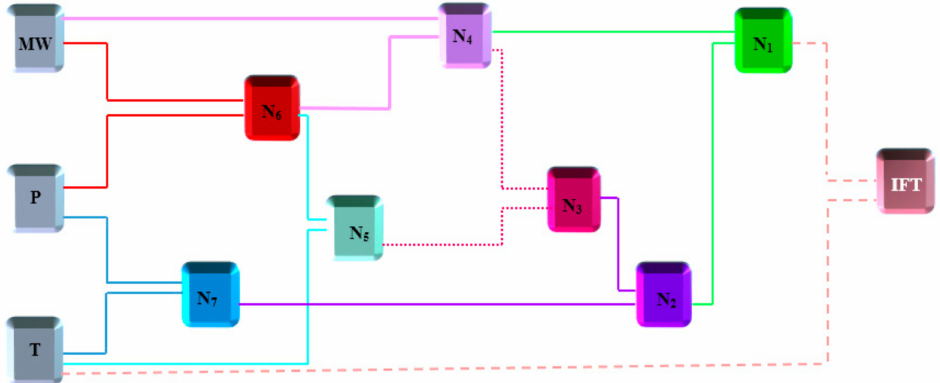
Figure 1. Schematic of the network of GMDH for estimating IFT between CO 2 and n-alkane. with MW< 128 g · mol − 1